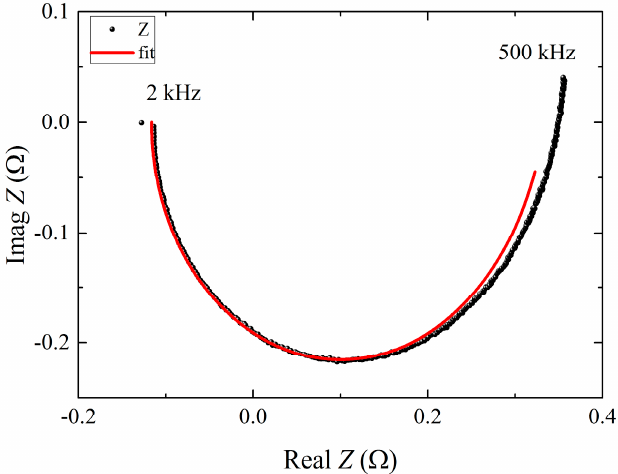
Figure 4. Measured (dots) device impedance Z at R 0 bias point and the corresponding fit (line) between 2 kHz and 500 kHz of frequencies.